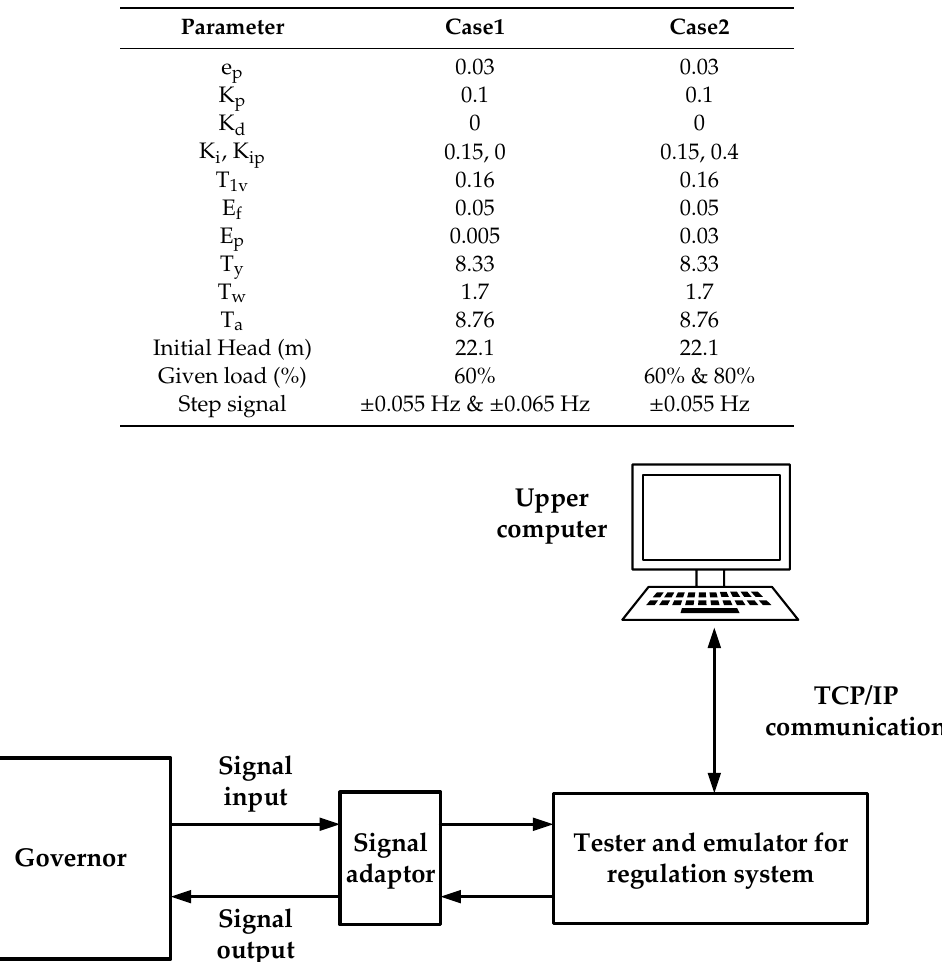
Table A5. Parameter setting of simulation experiment.